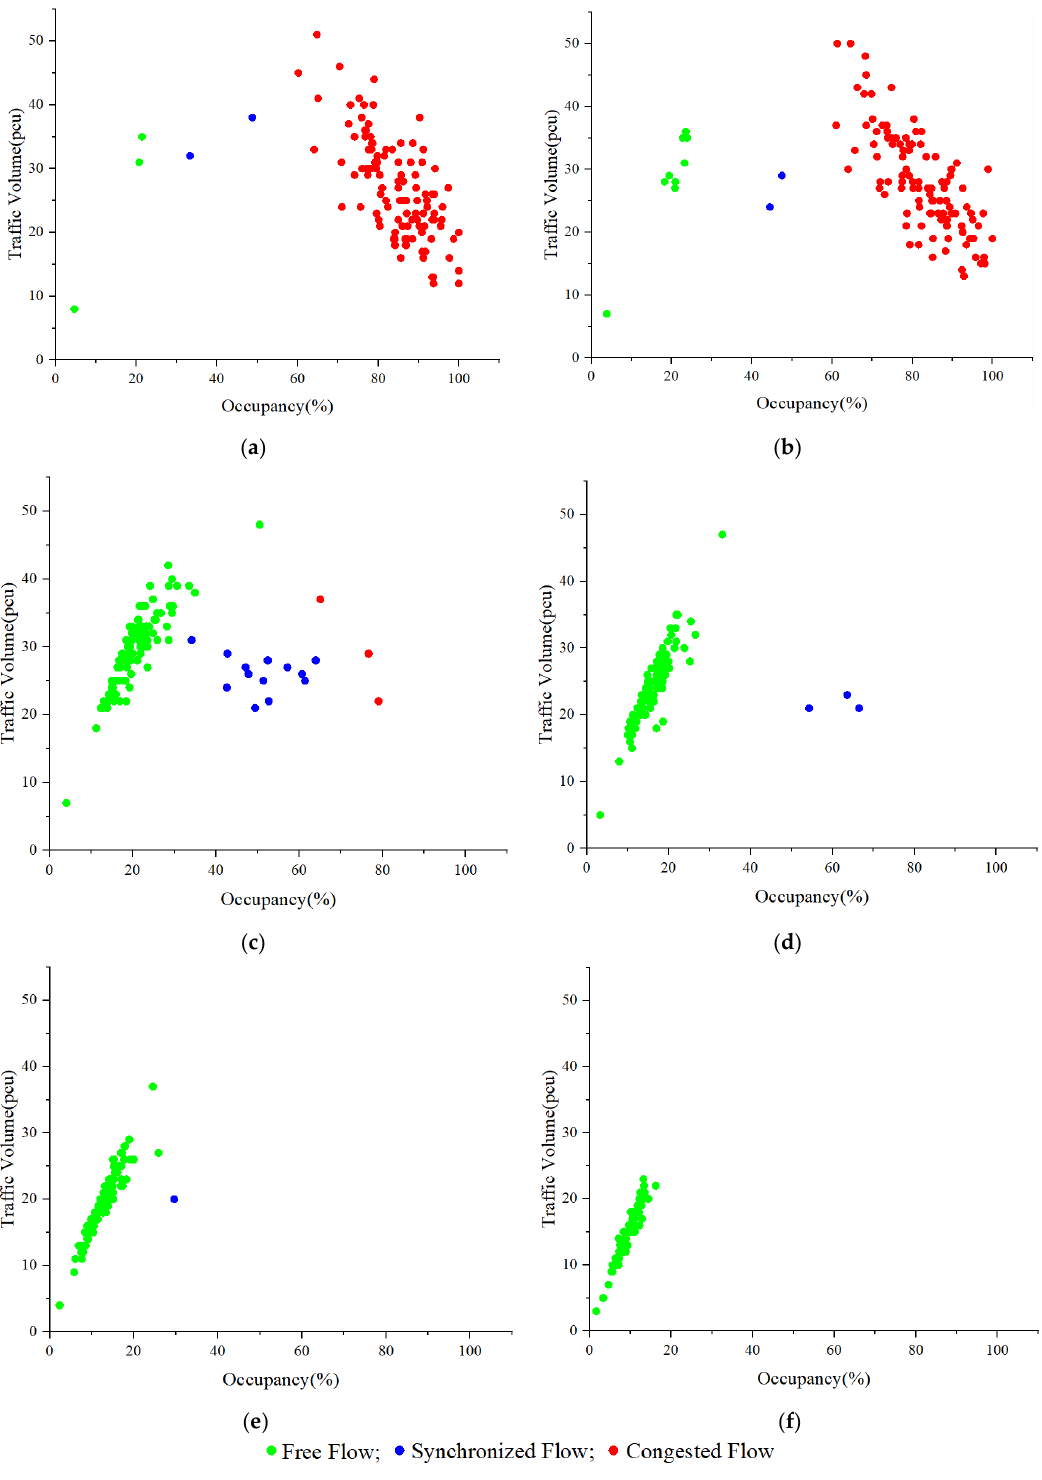
Figure 9. Distribution of traffic volume as a function of occupancy during congestion